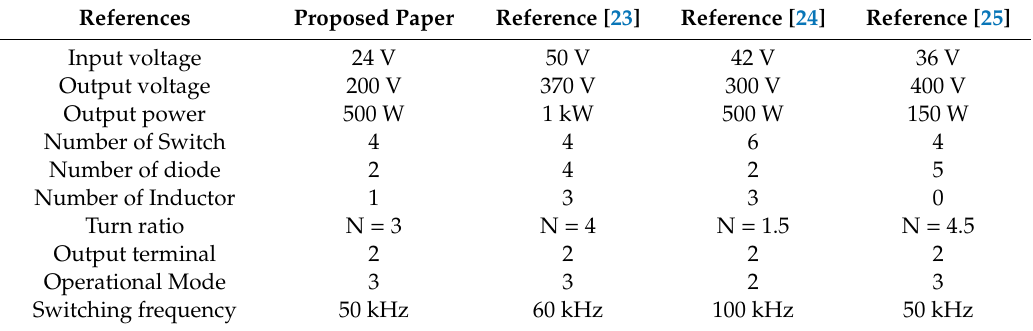
Table 2. Comparison of proposed converter with previously reported three-port converters.